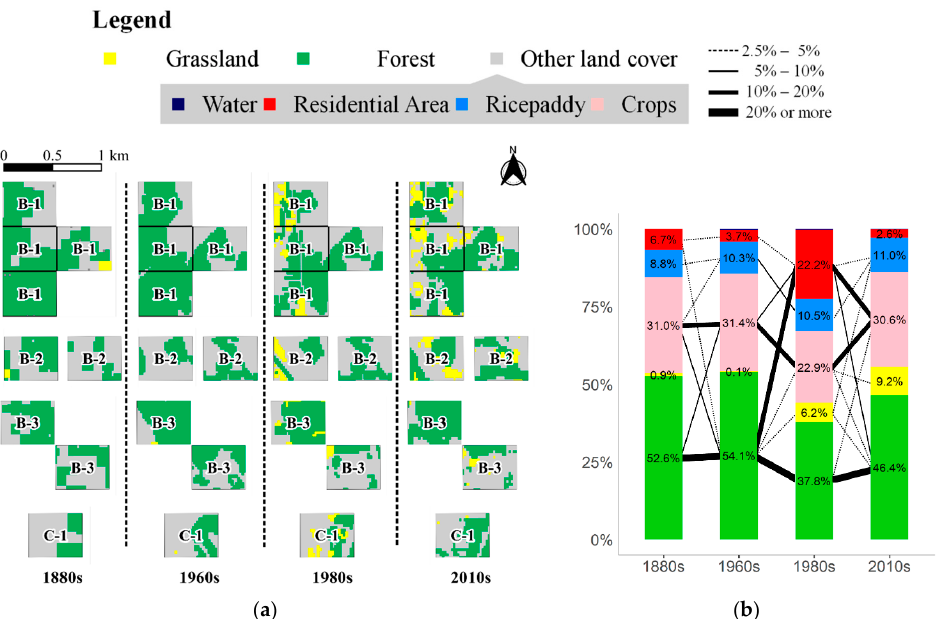
Figure 6. The time series land cover map and changes in land cover types in the grids that belong to three rural communities. ( a ) shows the land cover map between the 1880s and 2010s focused on the natural environments (Forest and Grassland). ( b ) shows the changes in land cover types between the 1880s and 2010s. The value in each bar represents the percentage (%) of each land cover type. The connecting line between two bars indicates the change in land cover type through the periods. The thickness of the line corresponds to the proportion of the changed area with respect to the grids shown in ( a ). The line was omitted if the proportion is less than 2.5%.